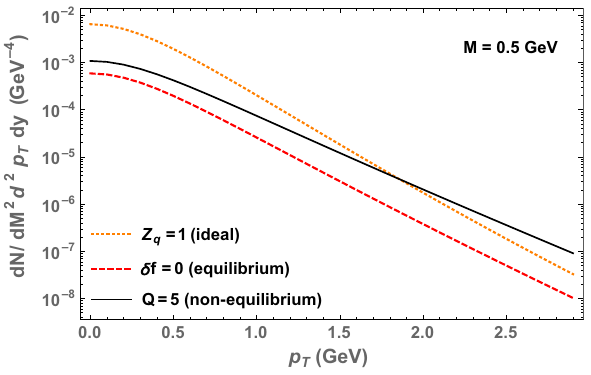
Fig. 4 Strength of non-equilibrium terms via the ratio R p